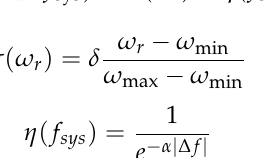
Figure 7. Structure of the proposed inertial control scheme.